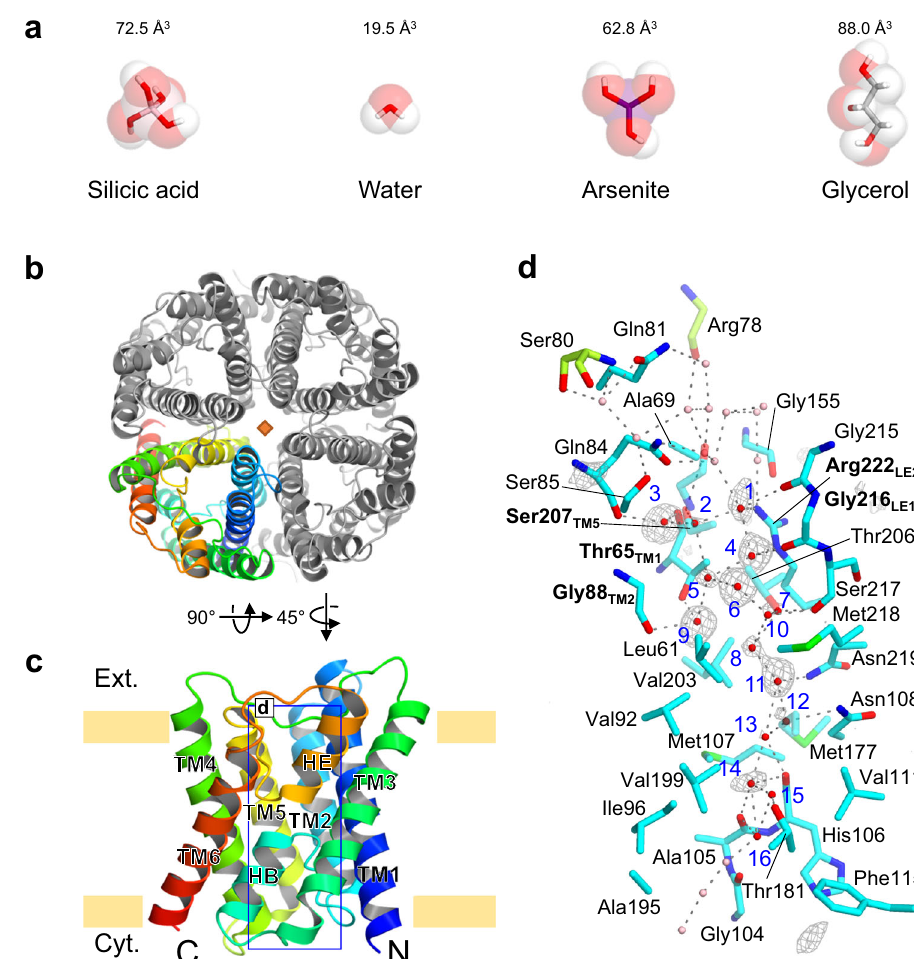
Fig. 1 Overall structure of the rice Si channel Lsi1 at a resolution of 1.8 Å. a Structures and the van der Waals volumes of water, glycerol, and metalloid (Si, As) transported by aquaporin. b The overall structure of the Lsi1 cryst tetramer is viewed from the extracellular side. A pseudo- C 4 symmetric axis is represented by a diamond shape. c Side view of the monomeric Lsi1 cryst , rainbow-colored with the N terminus in blue. The khaki bars indicate the membrane boundaries. d A close-up view of the channel region (chain C). Hydrogen bonding network (dot lines) shows interactions of the water molecules and the residues facing the channel ’ s pore. Key residues comprising the ar/R SF are highlighted by bold letters. Two residues (Arg78 and Ser80) in green color are from an adjacent subunit. Water molecules positioned in the channel (red) and extra/intracellular regions (pink) are shown. Water molecules in the channel are labeled in blue, and with the omit map (gray) contoured at + 3.5 ơ